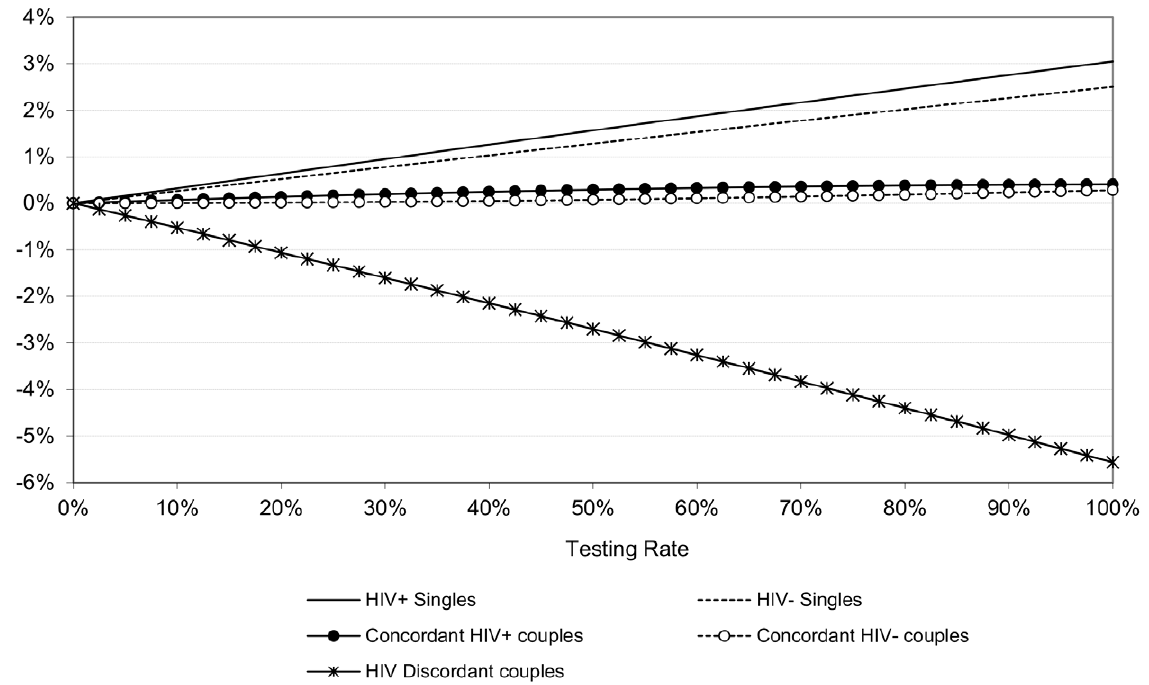
Figure 1. Estimated change in the percentage of the total population in various relationship types at different HTC coverage rates (monogamy model with baseline parameter values).